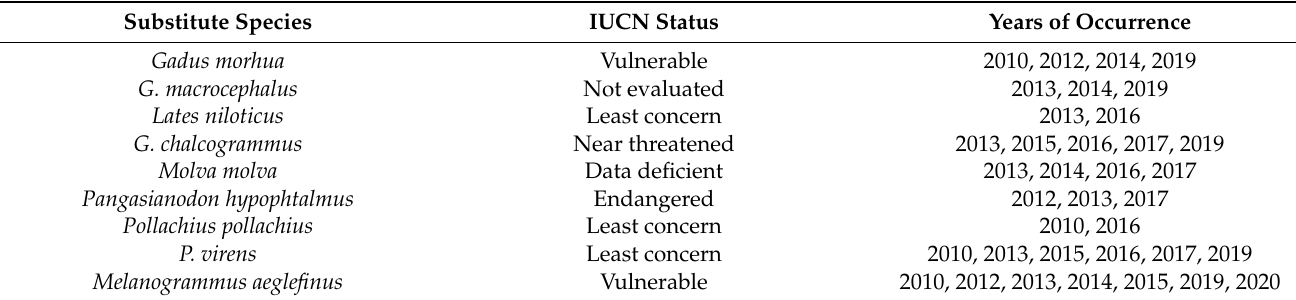
Table 3. The years each substitute species was found ( G. morhua was substitute species of G. macrocephalus ). IUCN, International Union for Conservation of